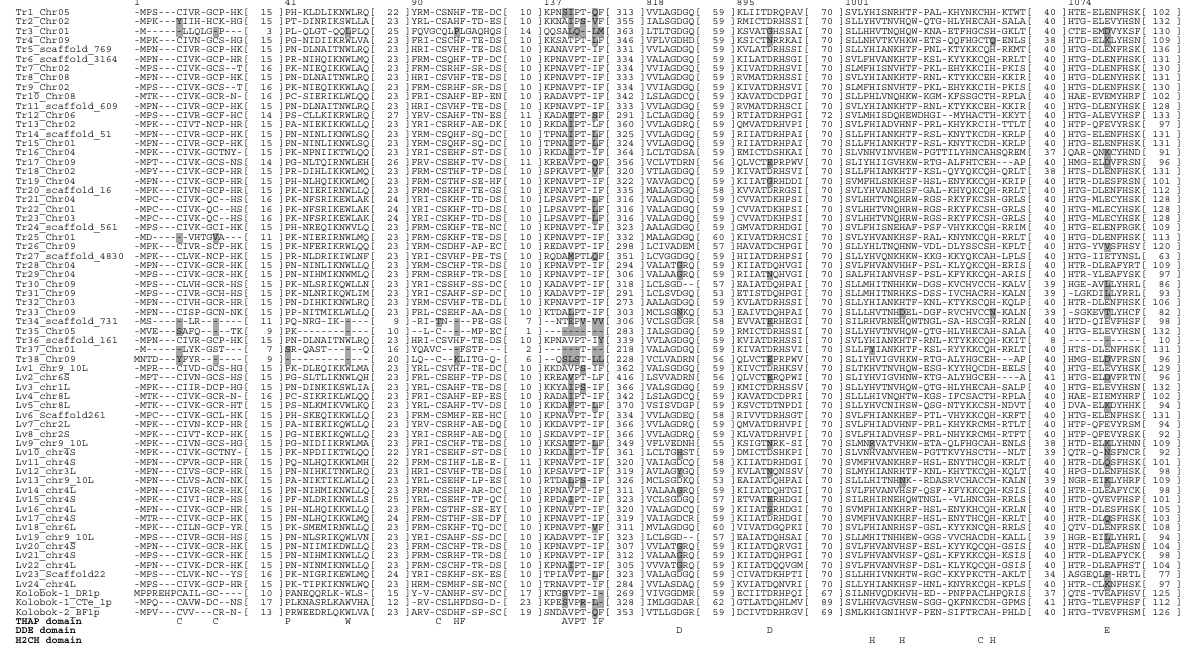
Fig. 1 Conserved regions of prospective XKol transposase CDSs. Conserved regions in a multiple alignment of prospective transposases predicted from the putative CDSs of XKol -Tpase genes with three outgroup transposases ( Danio rerio Kolobok-1_DR, Capitella teleta Kolobok-1_CTe, and Branchiostoma floridae Kolobok-2_BF). Numbers above the alignment indicate the position of the amino acids in it (Additional file 1: Figure S1). Numbers in square brackets are the abbreviated amino acids. Consensus residues of conserved domains (DDE, THAP, and H2CH) are shown below the alignment. Nonconserved amino acid residues in conserved motifs are marked by gray